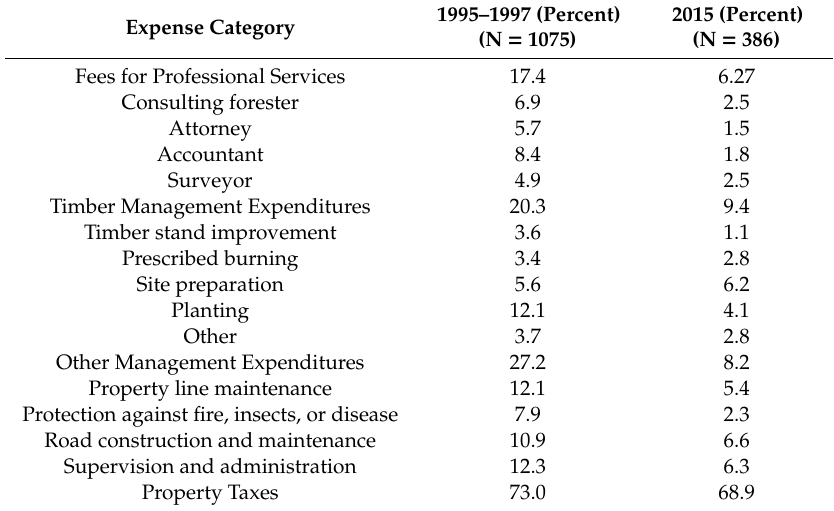
Table 3. Percentage of respondents who incurred forest management expenses, Mississippi, 1995–1997 and 2015.